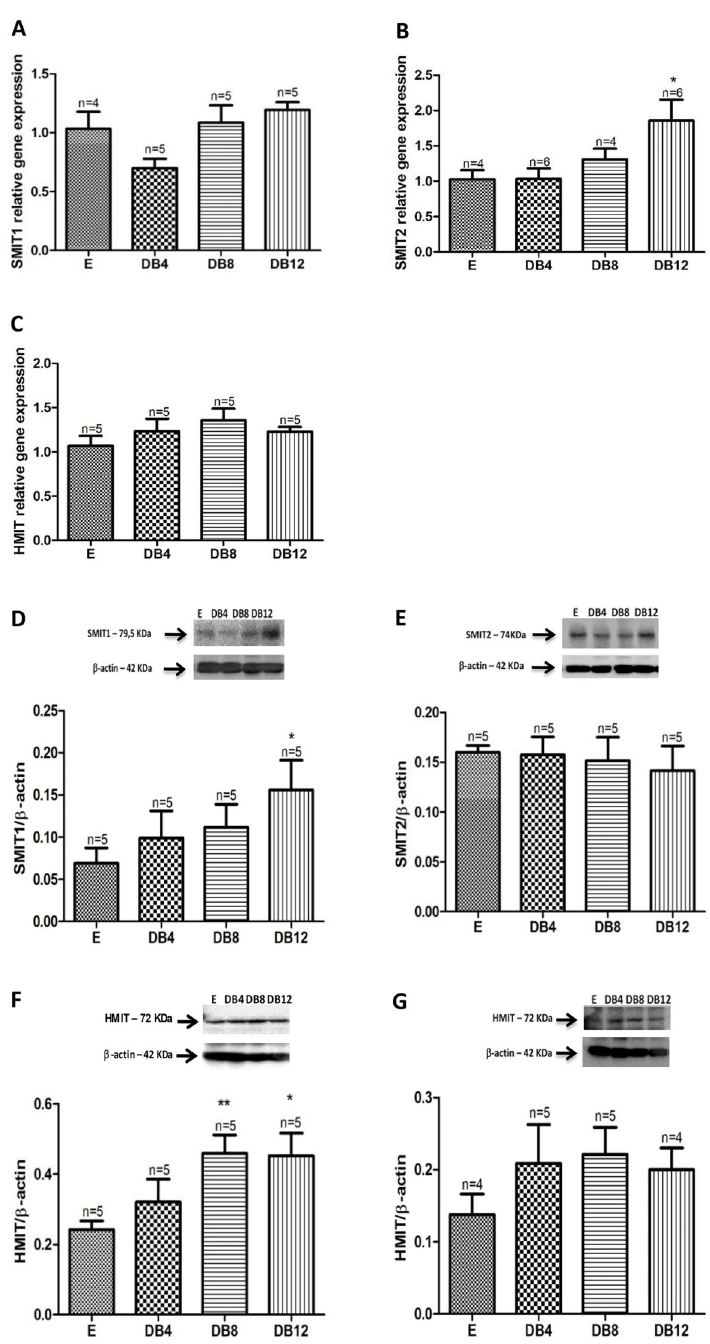
groups compared to the E controls (increase of 89.25 and 86.36 %, respectively). In the membrane fraction of the dorsal root ganglia, we observed a trend toward enhance- ment in HMIT expression in all DB groups studied.